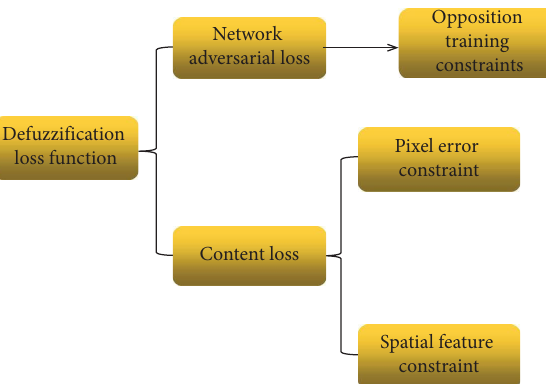
Figure 8: Overall design of the deblurring